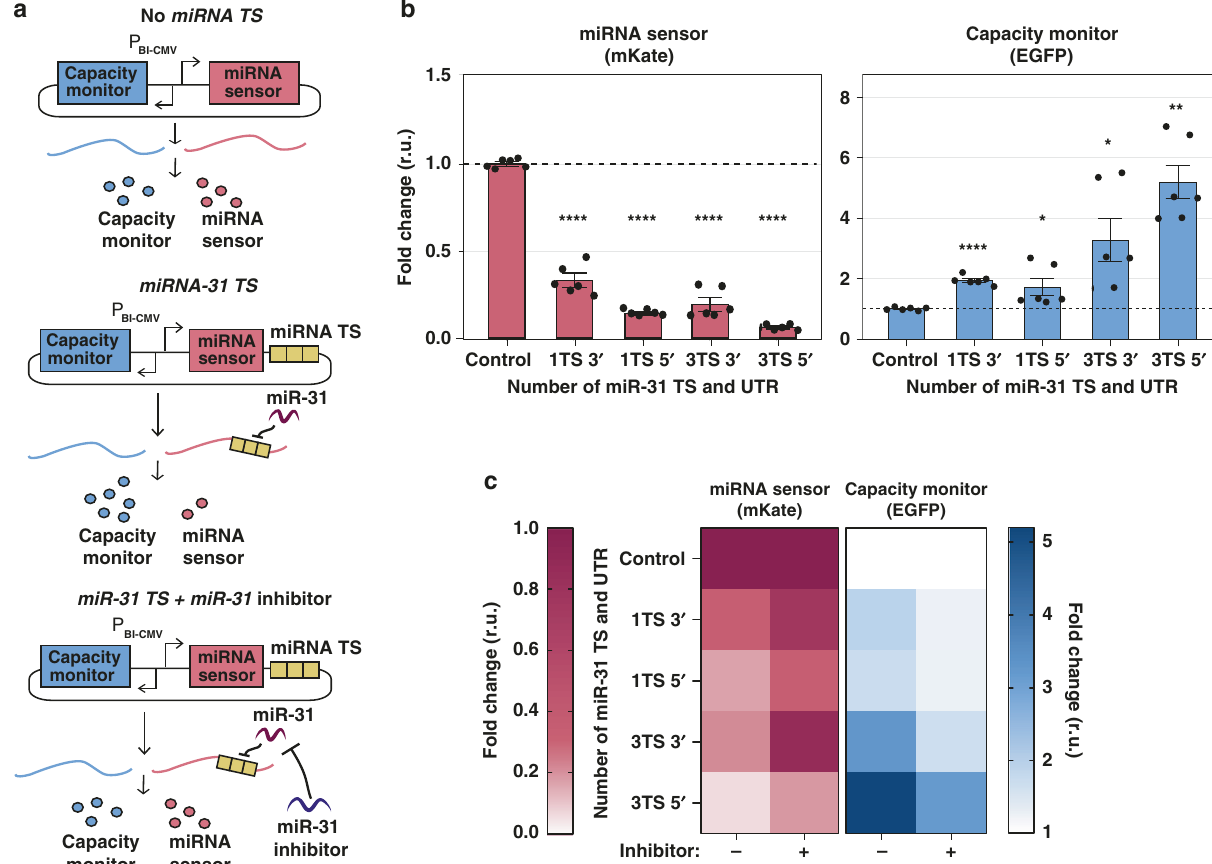
Fig. 3 Impact of miRNA target sites number and location on burden. a Schematics of experimental design to infer miRNA-mediated cellular resources redistribution. EGFP (capacity monitor) and mKate (miRNA sensor) are encoded on the same bidirectional CMV promoter plasmid. One or 3 TS for miR-31 (TS) are added either in the 3 ′ or 5 ′ UTR of mKate. Control: no miR-31 TS. Hypothesis: in the absence of miR-31 regulation, capacity monitor and miRNA sensor are expressed to a certain level (top). In the presence of miR-31, lower miRNA sensor levels correlate with higher capacity monitor expression (middle). This condition is reversed by an miR-31 inhibitor (bottom). b Fold change of miRNA sensor and capacity monitor protein levels compared to control (set to 1). EGFP increases up to fi vefold with the strongest downregulation of mKate (3 TS 5 ′ UTR). Flow cytometry data were acquired 48 h post- transfection and are plotted as mean ± SE. SE standard error, r.u. relative units. N = 6 biological replicates. Source data are provided as a Source Data fi le. Unpaired two-sided T -test. P value: ****<0.0001, **<0.005, *<0.05. c When miR-31 activity was impaired by a miR-31 inhibitor, the rescue of mKate expression corresponds to reduced EGFP levels, whereas both fl uorescent proteins do not vary in the control. The heatmaps represent the fold change derived by fl ow cytometry data, calculated as the ratio between the geometric mean of six biological replicates and the corresponding geometric mean in the control condition. Source data are provided as a Source Data fi le. Bar plots and statistical analysis are reported in Supplementary Fig.